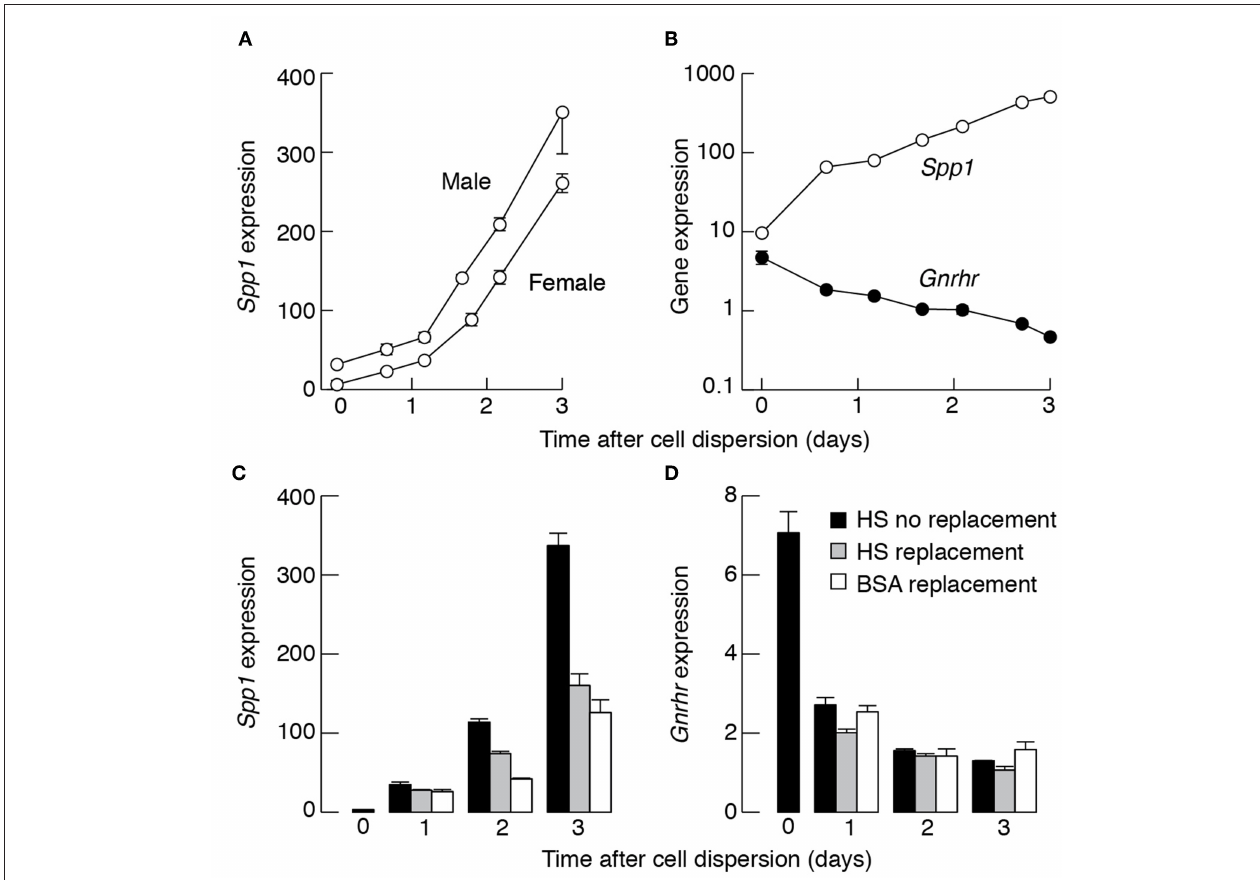
FIGURE 7 | Culturing of dispersed pituitary cells stimulates Spp1 expression. (A) The time course of basal Spp1 expression in cultured pituitary cells. Cells were derived from 7-week-old female and male rats. Zero indicates Spp1 expression levels immediately after cell dispersion. Cells were cultured in medium 199 containing horse serum. (B) Opposite effects of dispersion and culturing of pituitary cells from females on Spp1 and Gnrhr expression. In (A) and (B) , cells were continuously cultured in medium 199 containing horse serum without replacement of old medium with fresh. (C,D) Effects of replacement of culturing medium on rate of basal Spp1 (C) and Gnrhr (D) expression. Old media were replaced with fresh media after 12, 36, and 60h incubation and cells were collected for mRNA extraction immediately after dispersion, and 24, 48, and 72h after dispersion.